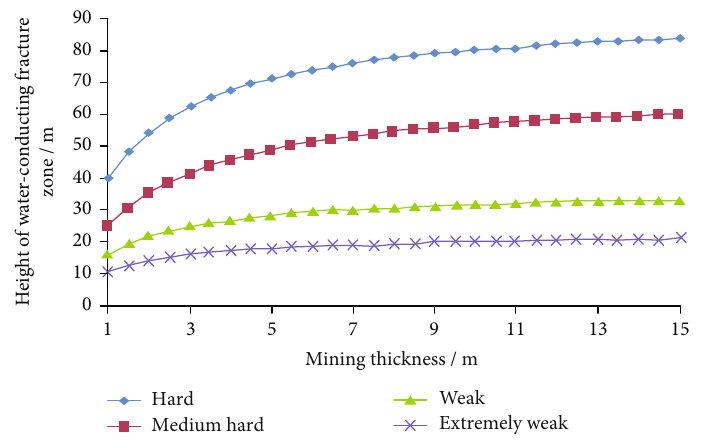
Figure 2: Relationship between mining thickness and height of the water-conducting fracture zone with di ff erent lithology [25].